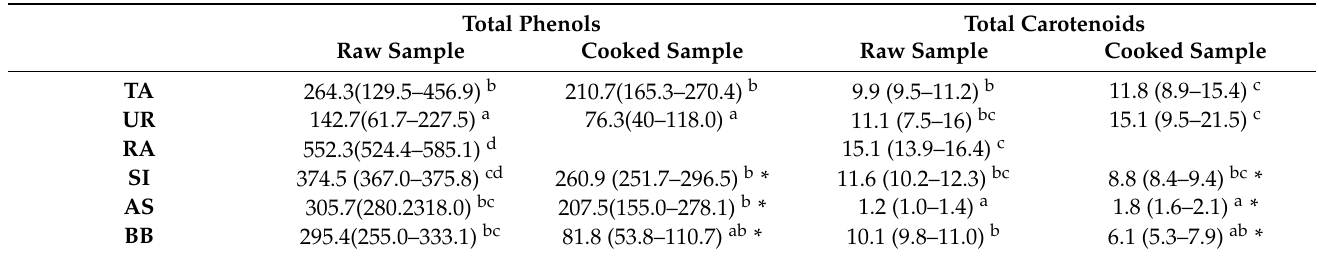
Table 6. Total phenol (mg GAE/100 g FW) and carotenoid (mg/100 g FW) contents analyzed by using spectrophotometric methods, in wild raw and cooked samples. Total Phenols Total